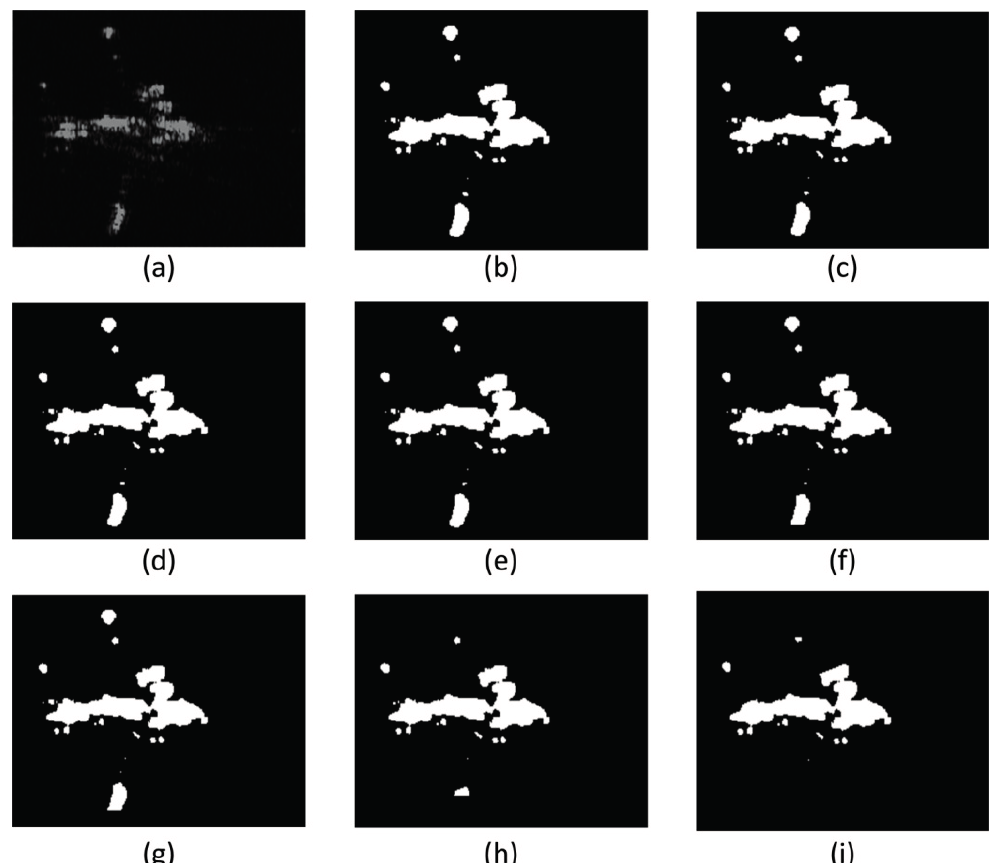
Figure 11. Radius of local window’s influence on detection result. ( a ) is the original image for example; ( b ) is the result of window with radius of 2 pixels; ( c ) is the result of window with radius of 4 pixels; ( d ) is the result of window with radius of 6 pixels; ( e ) is the result of window with radius of 8 pixels; ( f ) is the result of window with radius of 10 pixels; ( g ) is the result of window with radius of 12 pixels; ( h ) is the result of window with radius of 24 pixels; ( i ) is the result of window with radius of 36